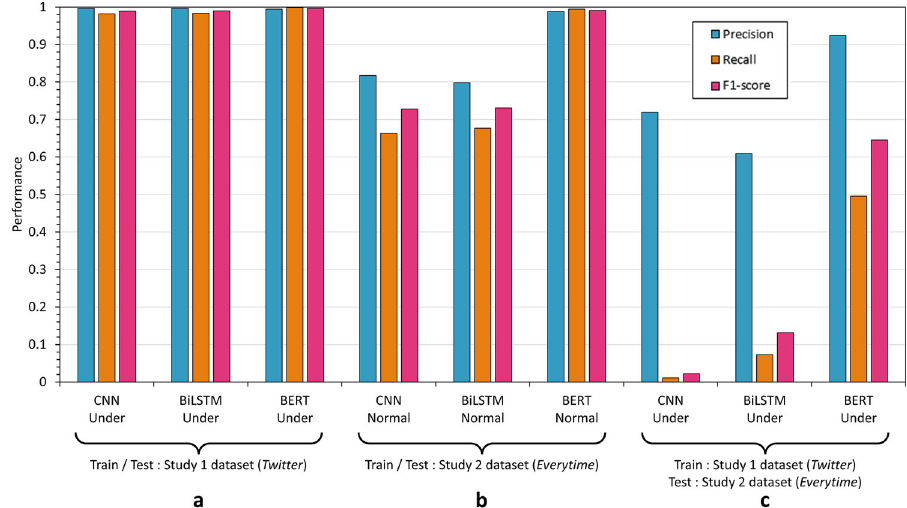
Fig. 3 Summary of the results. a Korean Twitter dataset (Study 1). b Everytime dataset (Study 2). c Trained by Korean Twitter dataset and tested by Everytime dataset.